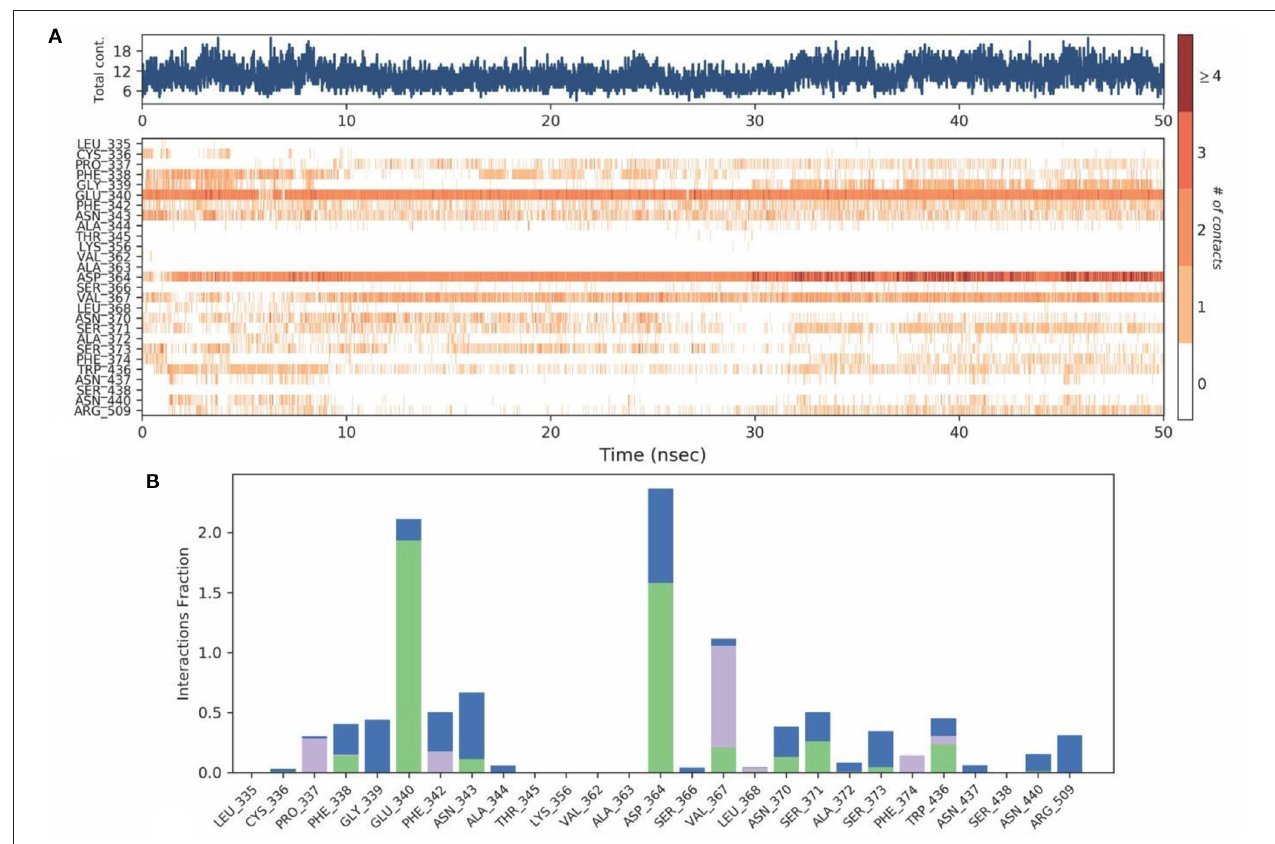
FIGURE 12 | (A) Protein-ligand contact map for 50ns duration for Spike protein and Tellimagrandin-II complex. (B) Protein - ligand contacts of Spike protein Tellimagrandin-II complex simulation (Blue, water bridges; Green, Hbonds; Violet,